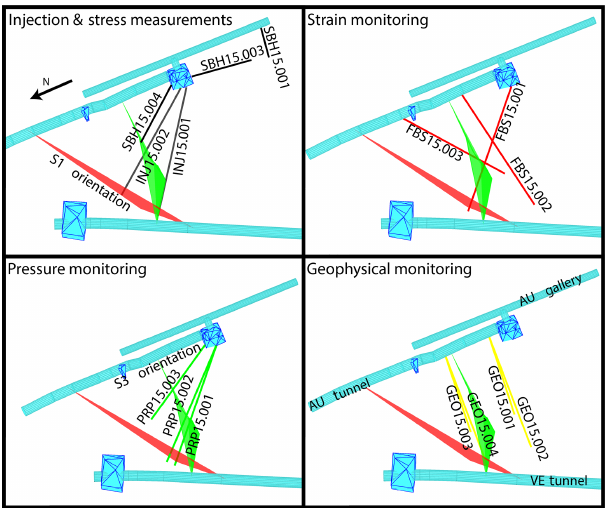
Figure 3. The 15 boreholes drilled for the ISC experiment (view steeply inclined towards the southeast).